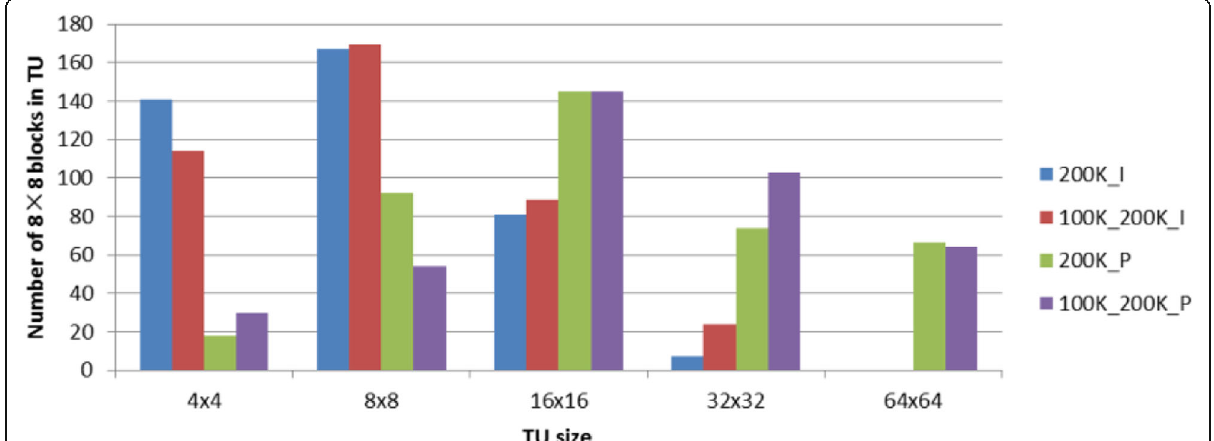
Fig. 5 The average number of each TU partition type in the first I/P frame of all GOPs of single (200k) and double (100k – 200k) compressed videos. ‘ 200k_I ’ ( ‘ 200k_P ’ ) means I (P) frame of a single compressed video with bitrate 200k. ‘ 100_200k_I ’ ( ‘ 100_200k_P ’ ) means I (P) frame of a double compressed video with bitrate 100k in the first compression process and 200k in the second compression process. The video for testing is the first part of video named “ akiyo ” in QCIF database. Information on video database can be found in Section 4